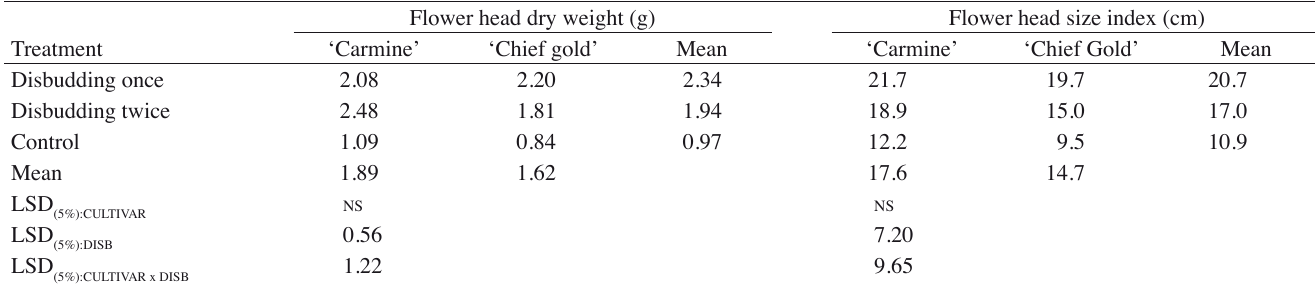
Flower head dry weight (g)